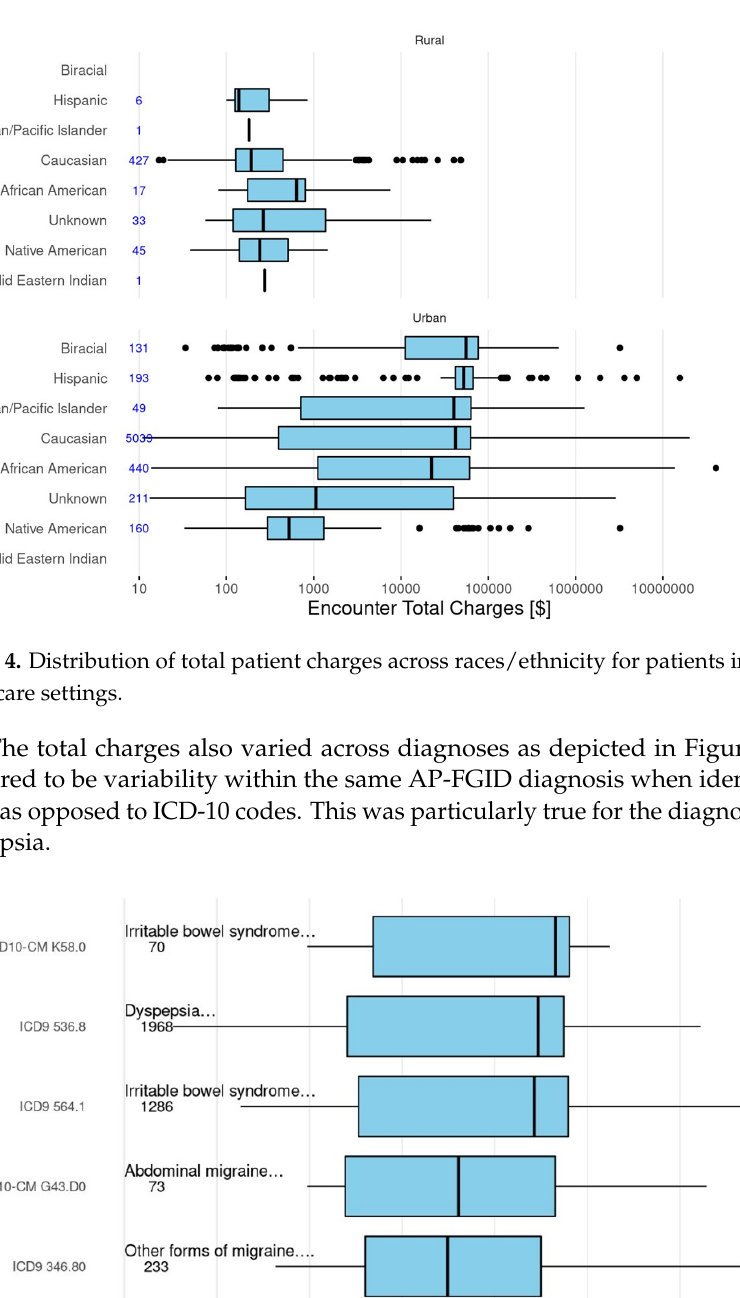
Figure 3. Distribution of total patient charges across races/ethnicity for children (8–12 years of age) and adolescents (13–18 years of age).